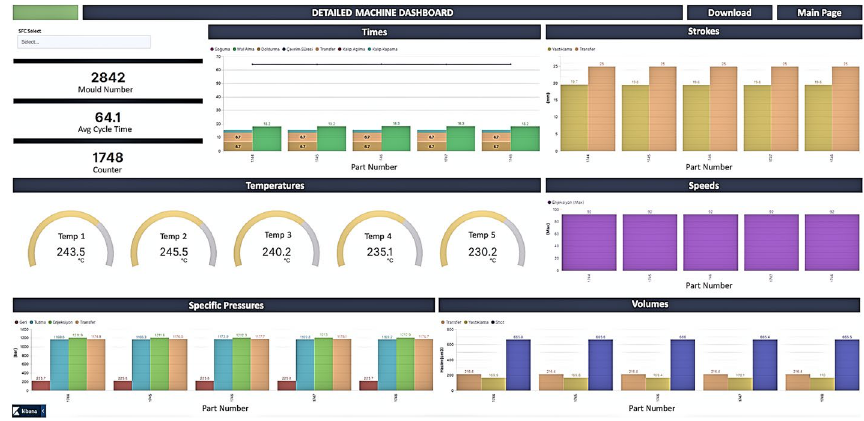
Fig. 10 Detailed machine dashboard shows near real-time process data such as pressure, time, volume, speed, and temperature. Plots on the dashboard are mostly grouped by part number. Users can compare different parts in terms of the process parameters by selecting part numbers using the drop-down menu on the left corner. This dashboard is refreshed automatically every 5